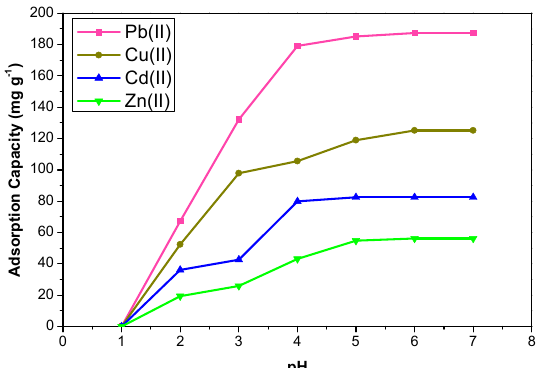
Figure 5. Effect of pH on the adsorption of studied metal ions on SiTF 5 PP . Adsorption dose: V = 10 mL, m = 10 mg of SiTF 5 PP at optimum concentration (187.36 ppm in each case), t = 30 min and 25 ◦ C. Lines just combine the points.